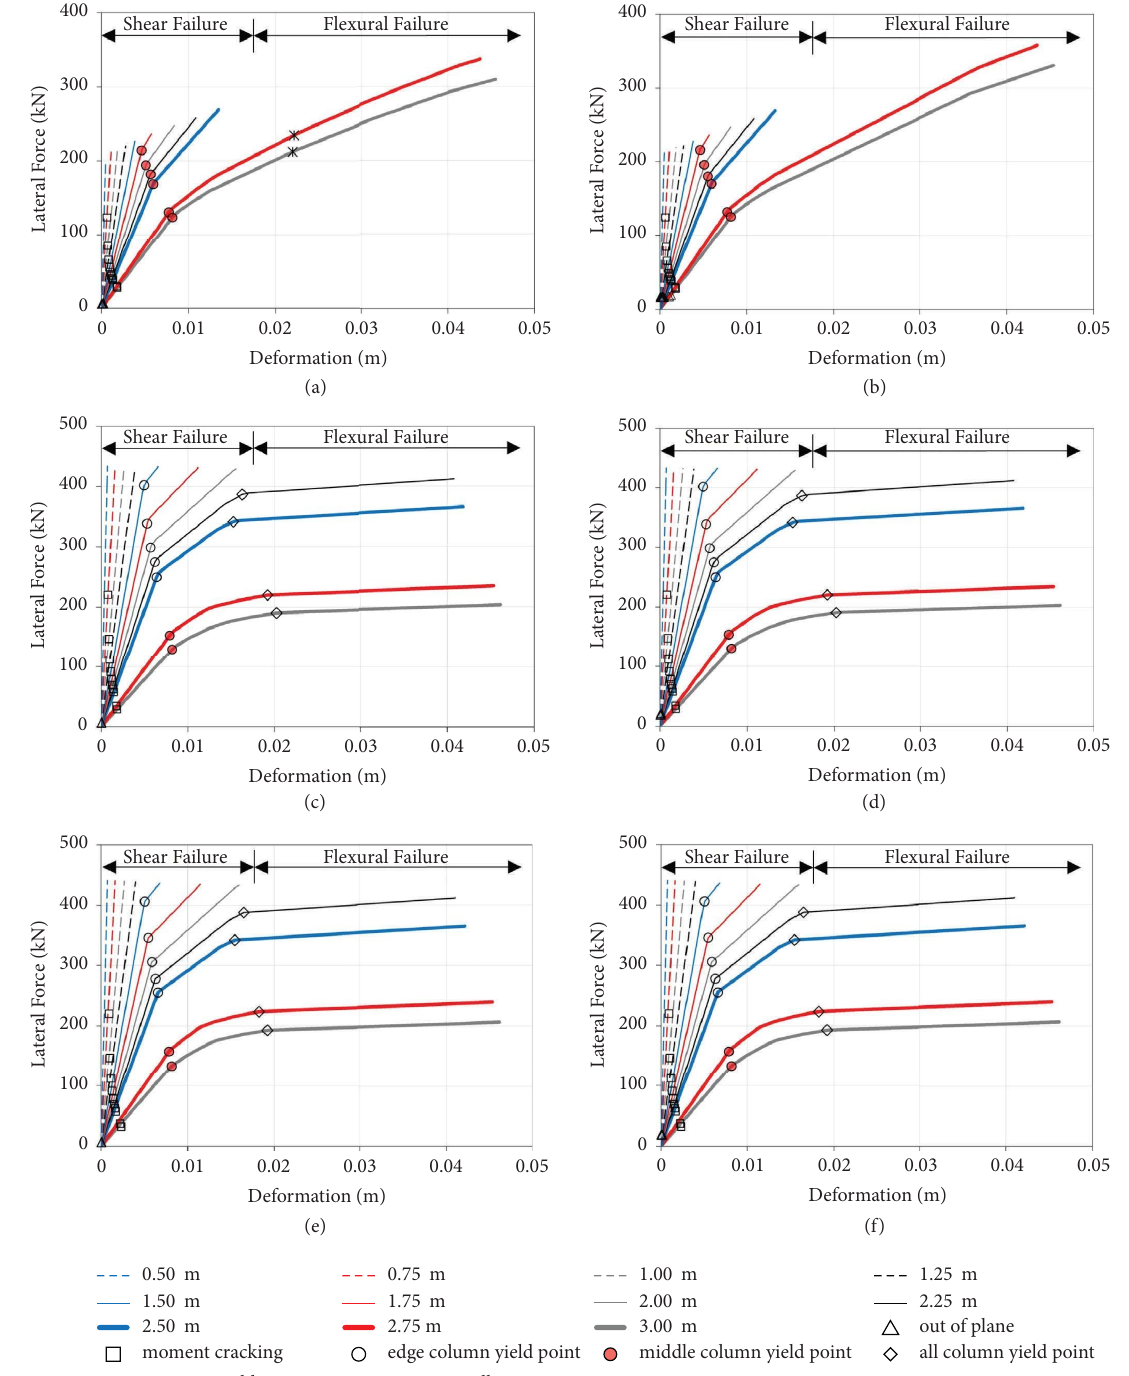
Figure 9: Relationship of lateral resistance and roof deformation of hollow brick walls (HB) and clay brick walls (CB) for 0 ° , 30 ° , and 60 ° fow directions. (a) HB-0 ° . (b) CB-0 ° . (c) HB-30 ° . (d) CB-30 ° . (e) HB-60 ° . (f) CB-60 °